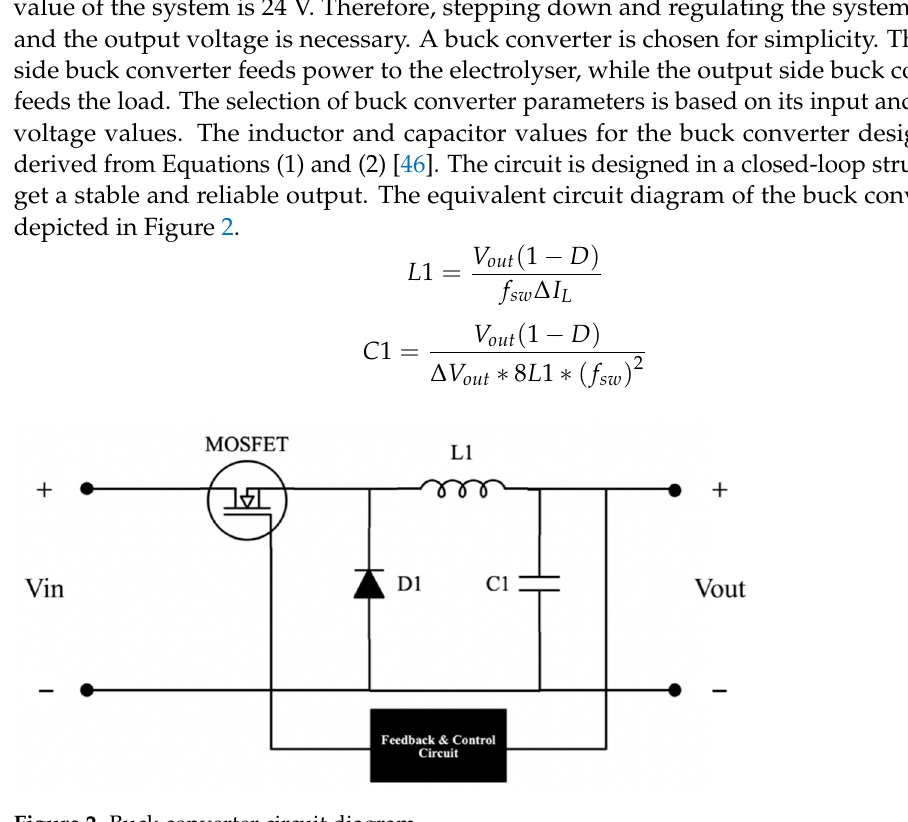
Figure 2. Buck converter circuit diagram.